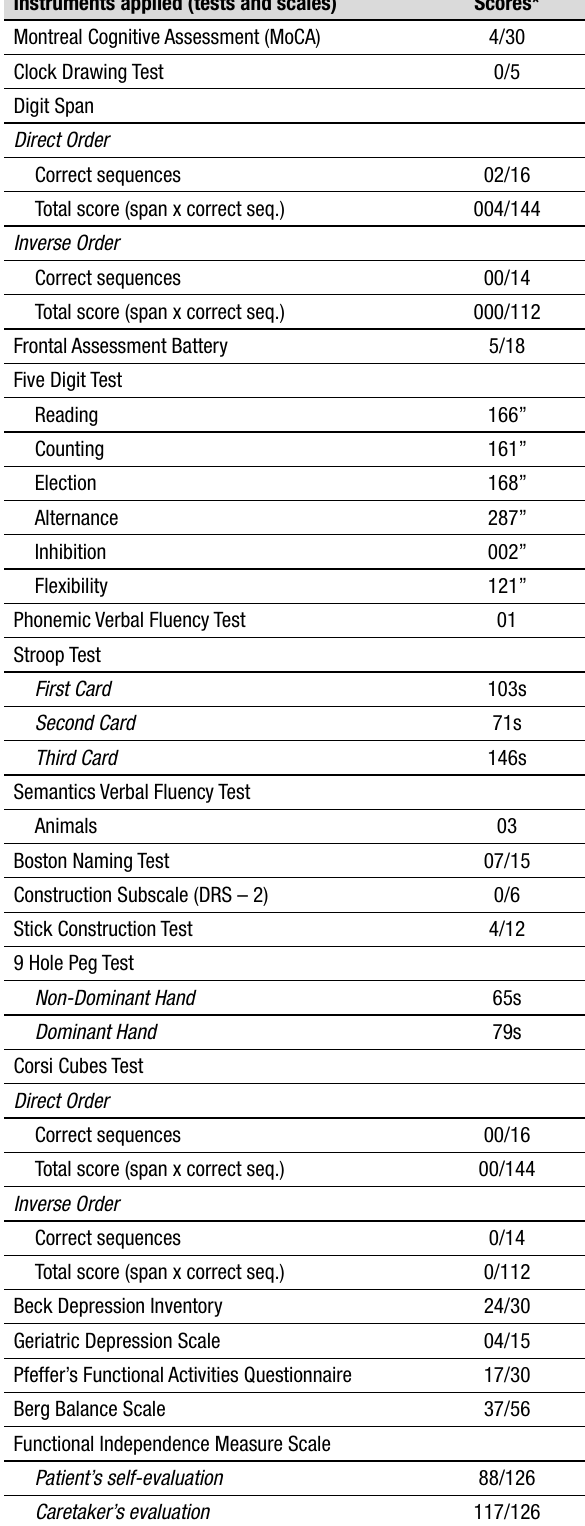
Table 1. Neuropsychological instruments and patient